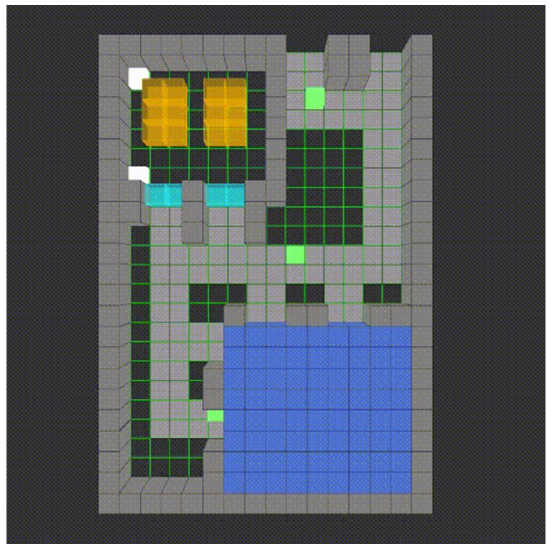
Figure 10. Overview of target distribution warehouse for modeling experiment (a snapshot of Figure10. Overviewoftargetdistributionwarehouseformodelingexperiment(asnapshotofsimulation simulation result visualization interface). result visualization